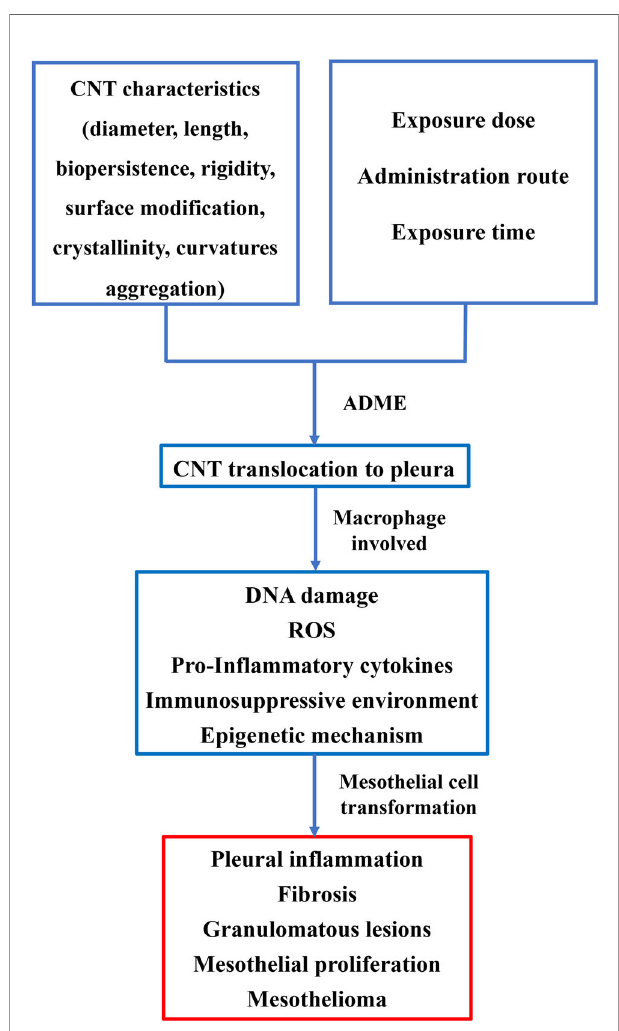
FIGURE 2 | Pathogenesis of MPM induced by CNT exposure. The characteristics of CNT, including length, diameter, surface modi fi cation, etc., can in fl uence pathological lesions on pleura. Administrative route, exposure time, and dose also play critical roles in lesion development of the pleura. Macrophages are involved in the process of transformation of mesothelial cells. A hypothesis of DNA damage in mesothelial cells, ROS, pro- in fl ammatory cytokines, and perturbed signaling pathway may thus be proposed in the transformation of mesothelial